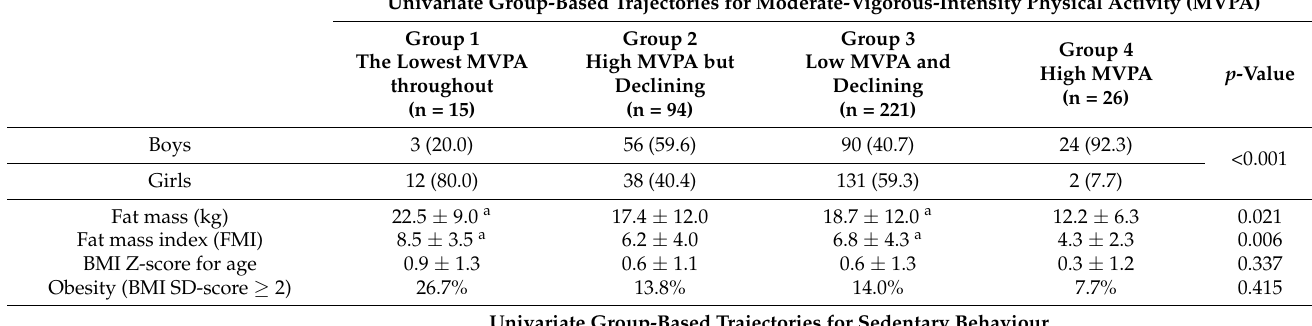
Table 2. Outcomes at age 15 in association with distinct trajectory